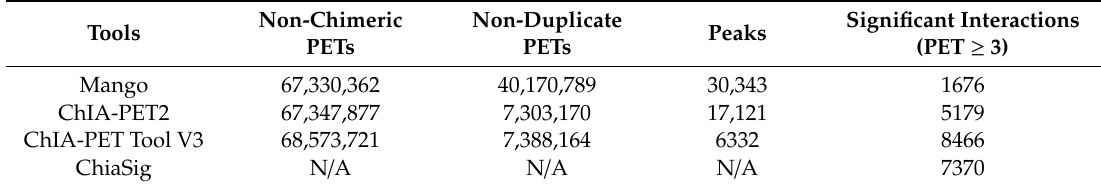
Table 8. Statistics of di ff erent tools from human K562 cells.